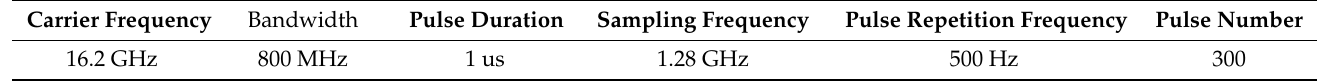
Table 1. Radar simulation